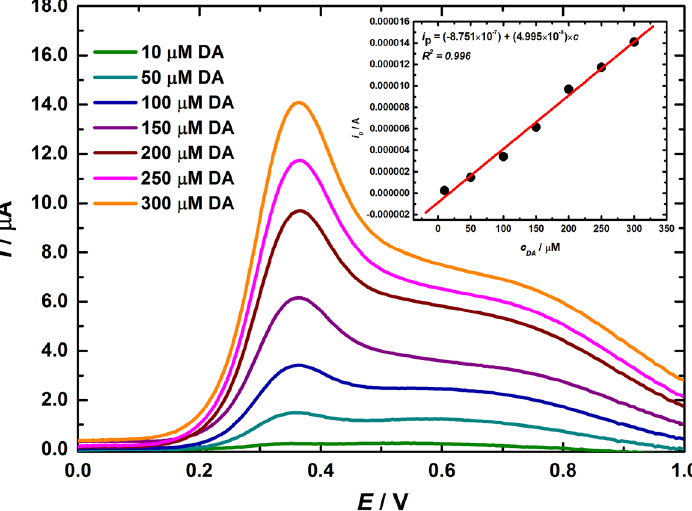
Figure 5. Background-subtracted differential pulse voltammograms obtained for various concentrations of dopamine (DA) at sample FTO/Mo6-45. Electrolyte: 0.1 M PB pH 7.0. Inset figure shows a calibration